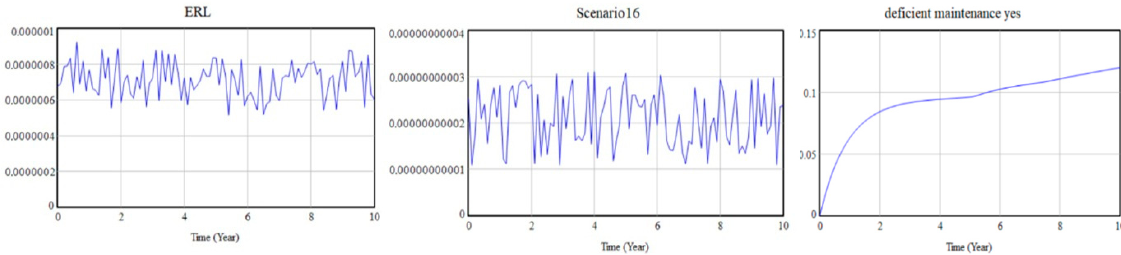
Figure A4. SD behaviour of risk over time.